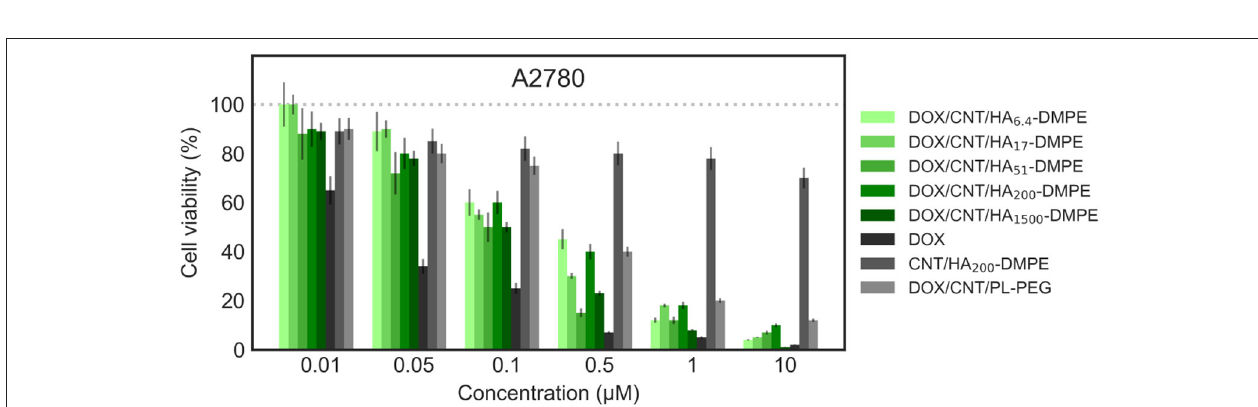
FIGURE 11 | Viability of the A2780 (CD44 − ) cell line when treated with various formulations at different concentrations for 24h. Cell viability was determined using the sulforhodamine B (SRB) assay as previously described in material and methods section.